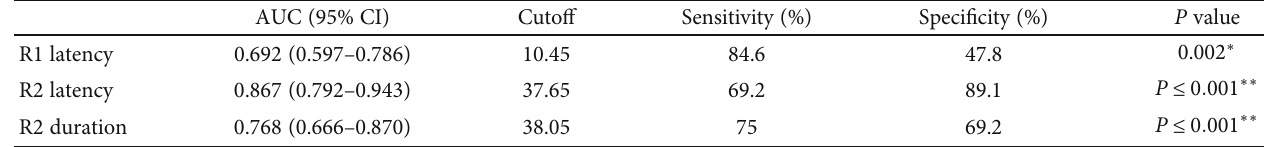
Table 7: Evaluation of blink re fl ex parameters in the diagnosis of dizziness.